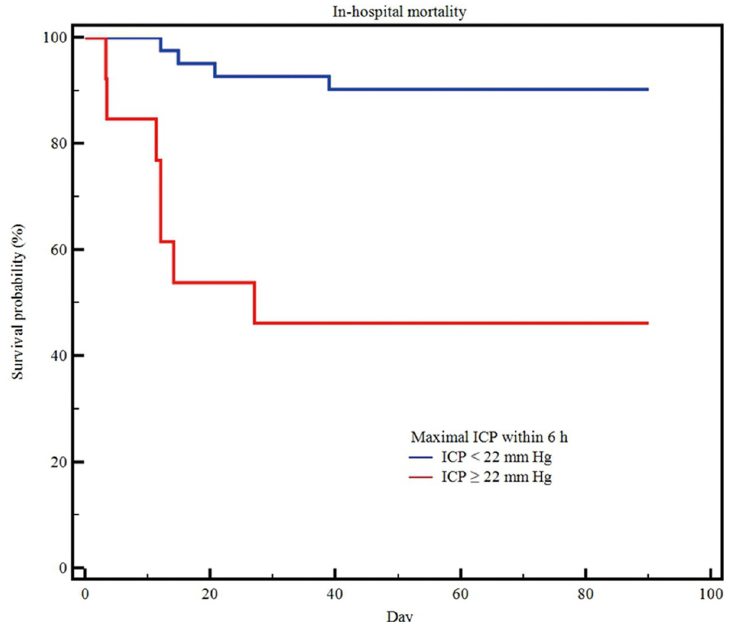
Fig 4. Kaplan-Meier three-month survival curves according to maximal intracranial pressure within 6 h after barbiturate coma therapy. Blue solid line, under 22 mm Hg; red solid line, over 22 mm Hg; adjusted hazard ratio 8.16, 95% CI, 2.373–28.056, p < 0.001, based on log-rank tests (n = 60).